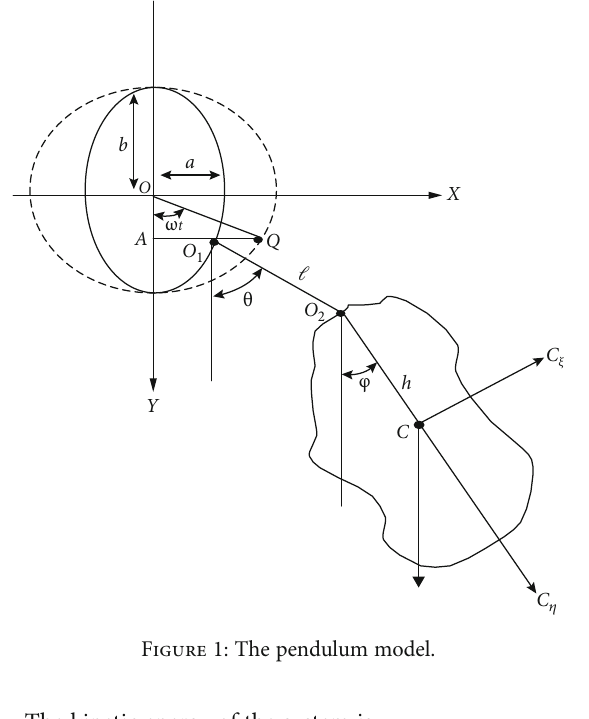
Figure 1: The pendulum